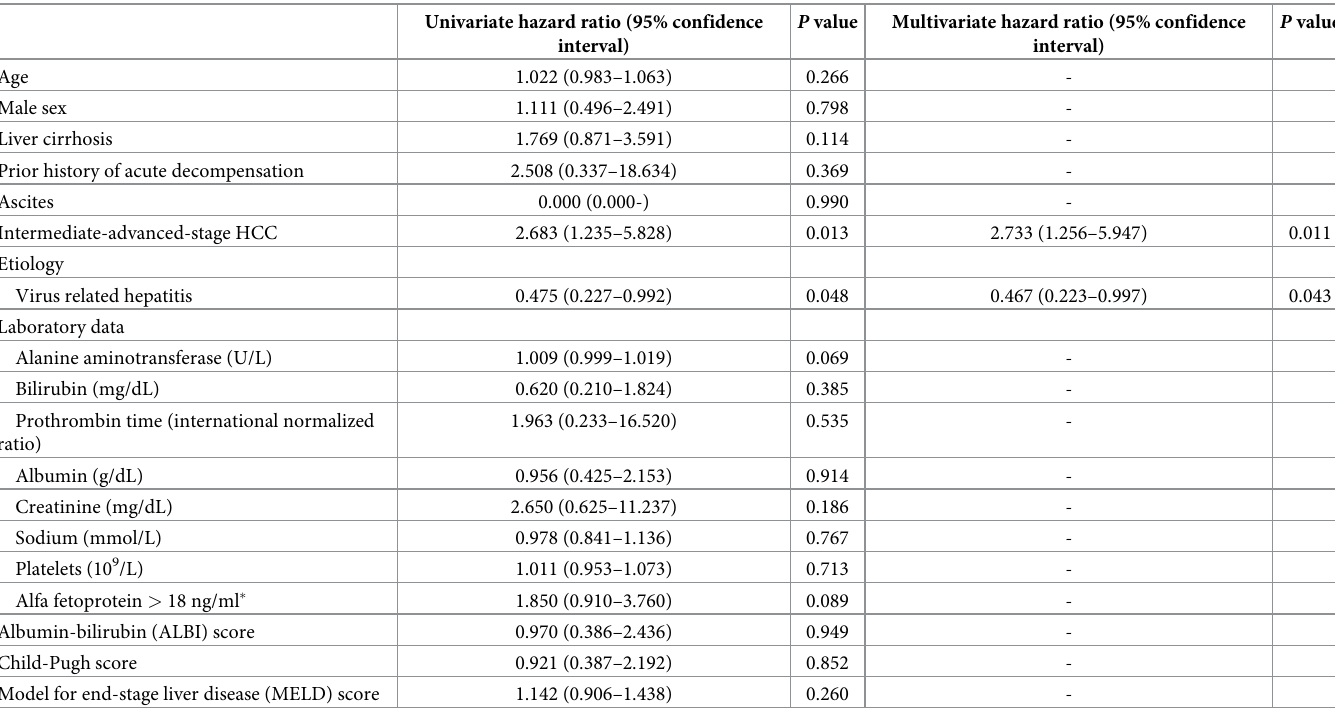
Table 3. Cox regression analyses of predictive factors for the development of acute decompensation in the surgical resection